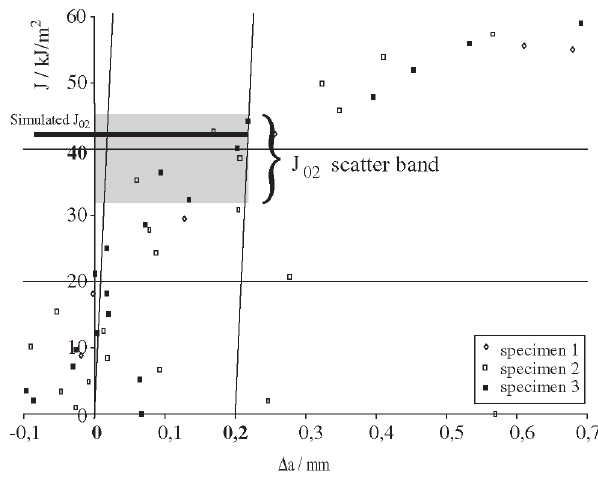
as compared to the 02